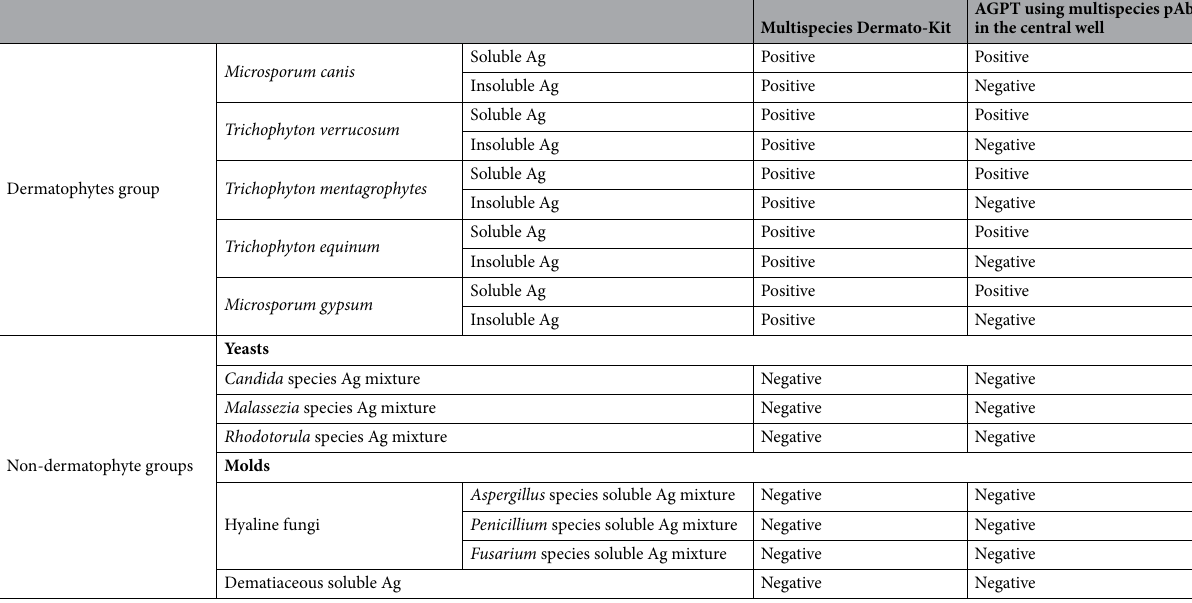
Table 1. Illustration of the validating testing outcome, of different keratinophilic dermatophytes and non- dermatophytes antigens, by both the newly developed kit and the agar gel precipitation test. Soluble Ag; is the submerged growth derived Ag, while insoluble Ag; is the superficial mycelial growth derived Ag.